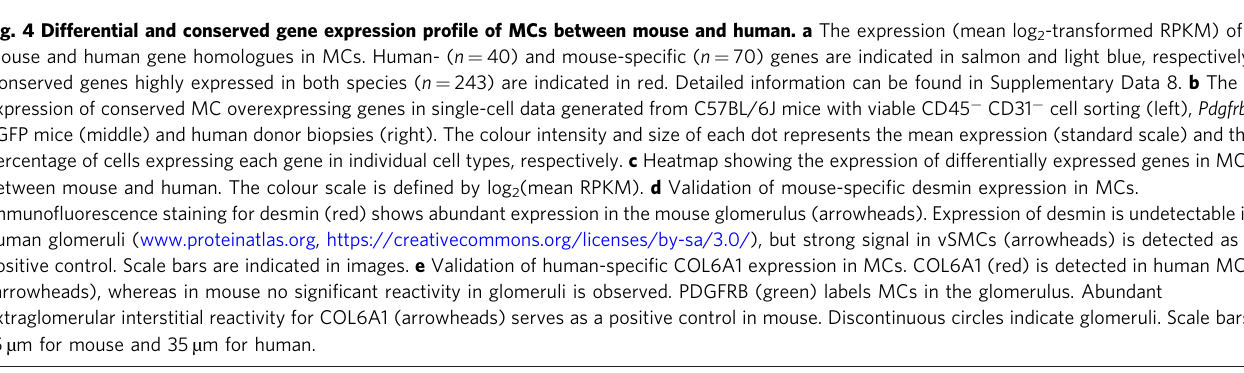
Fig. 4 Differential and conserved gene expression pro fi le of MCs between mouse and human. a The expression (mean log 2 -transformed RPKM) of mouse and human gene homologues in MCs. Human- ( n = 40) and mouse-speci fi c ( n = 70) genes are indicated in salmon and light blue, respectively. Conserved genes highly expressed in both species ( n = 243) are indicated in red. Detailed information can be found in Supplementary Data 8. b The expression of conserved MC overexpressing genes in single-cell data generated from C57BL/6J mice with viable CD45 − CD31 − cell sorting (left), Pdgfrb - EGFP mice (middle) and human donor biopsies (right). The colour intensity and size of each dot represents the mean expression (standard scale) and the percentage of cells expressing each gene in individual cell types, respectively. c Heatmap showing the expression of differentially expressed genes in MCs between mouse and human. The colour scale is de fi ned by log 2 (mean RPKM). d Validation of mouse-speci fi c desmin expression in MCs. Immuno fl uorescence staining for desmin (red) shows abundant expression in the mouse glomerulus (arrowheads). Expression of desmin is undetectable in human glomeruli (www.proteinatlas.org, https://creativecommons.org/licenses/by-sa/3.0/), but strong signal in vSMCs (arrowheads) is detected as a positive control. Scale bars are indicated in images. e Validation of human-speci fi c COL6A1 expression in MCs. COL6A1 (red) is detected in human MCs (arrowheads), whereas in mouse no signi fi cant reactivity in glomeruli is observed. PDGFRB (green) labels MCs in the glomerulus. Abundant extraglomerular interstitial reactivity for COL6A1 (arrowheads) serves as a positive control in mouse. Discontinuous circles indicate glomeruli. Scale bars: 15 µ m for mouse and 35 µ m for